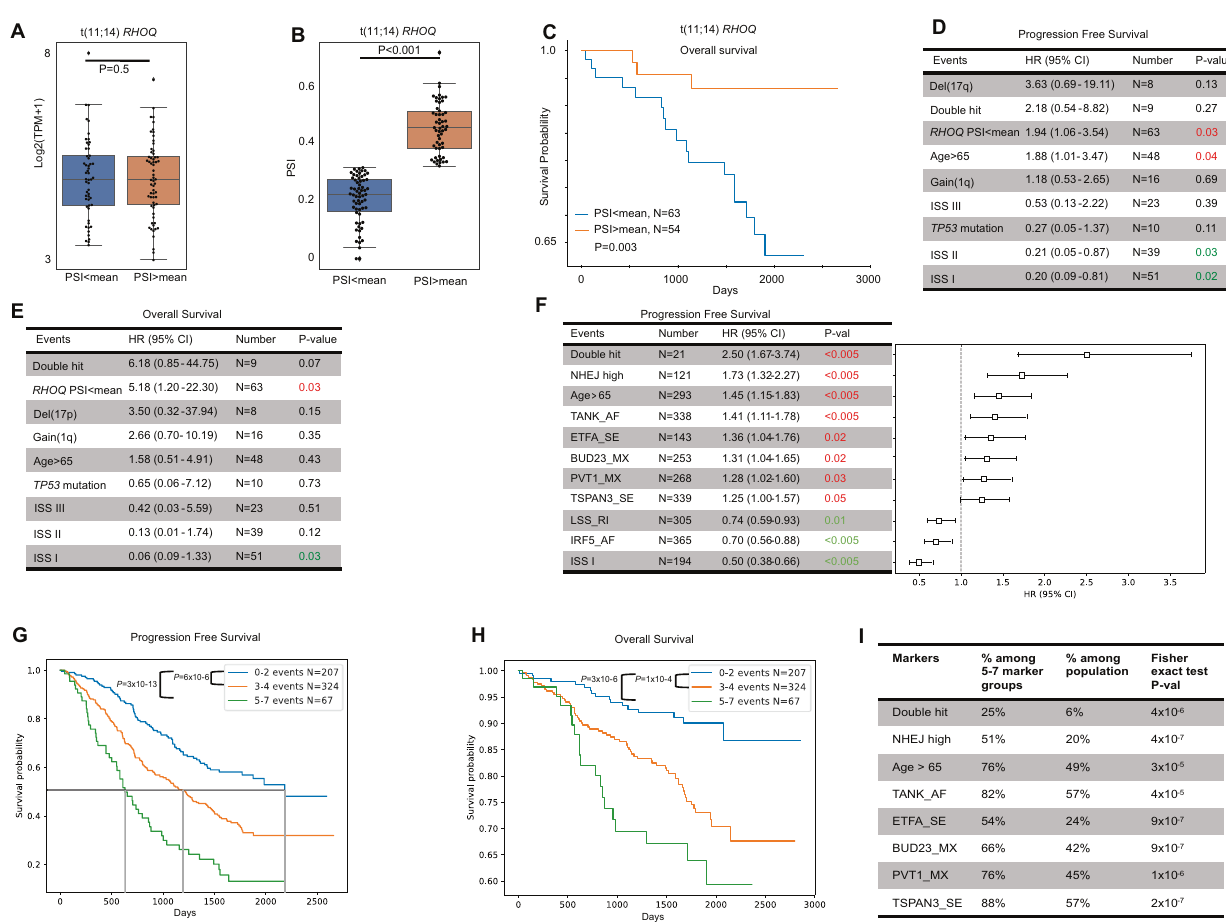
Fig. 4 Association of AS events and outcome. A Gene level expression of RHOQ in the two AS groups is the same in t(11;14) samples. B Splicing of the AF event in RHOQ in the two t(11;14) groups. C RHOQ splicing levels are associated with OS in t(11;14) patients. D , E Multivariate analysis of t(11;14) patients showing that the association of AS of RHOQ with poor PFS and OS is independent of other high- risk factors. F Predicted prognostic model of the 200 AS events with most variation across samples with well-known high-risk factors identi fi es 7 AS events associated with PFS. G , H Kaplan – Meier curves indicating the additive effects of samples carrying various number of the 10 poor prognostic markers de fi ned in F for PFS and OS. P -values from the Logrank test and median PFS are shown. I Percentage of poor prognostic markers within the high-risk group compared against the entire